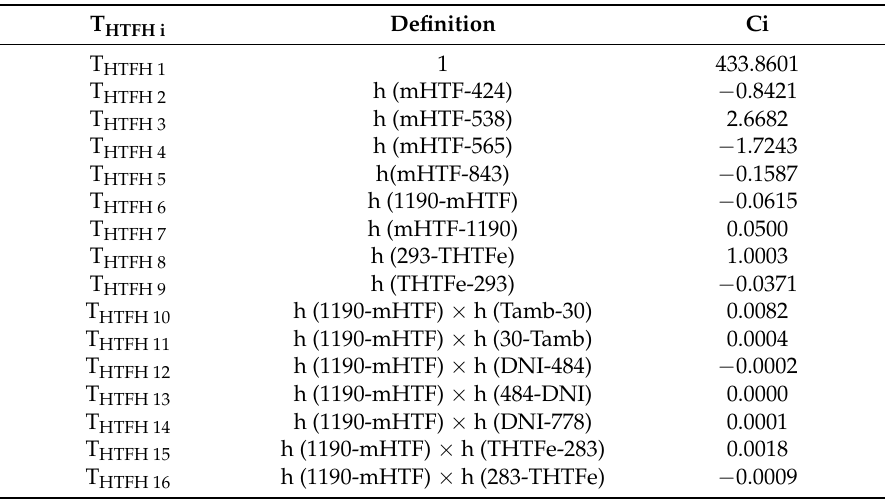
Table 5 defines the algorithm of MARS_2c [+Oil Thermal Inertia; +Mass Flow] model: Table 5. List of the base functions of the MARS model and their coefficients